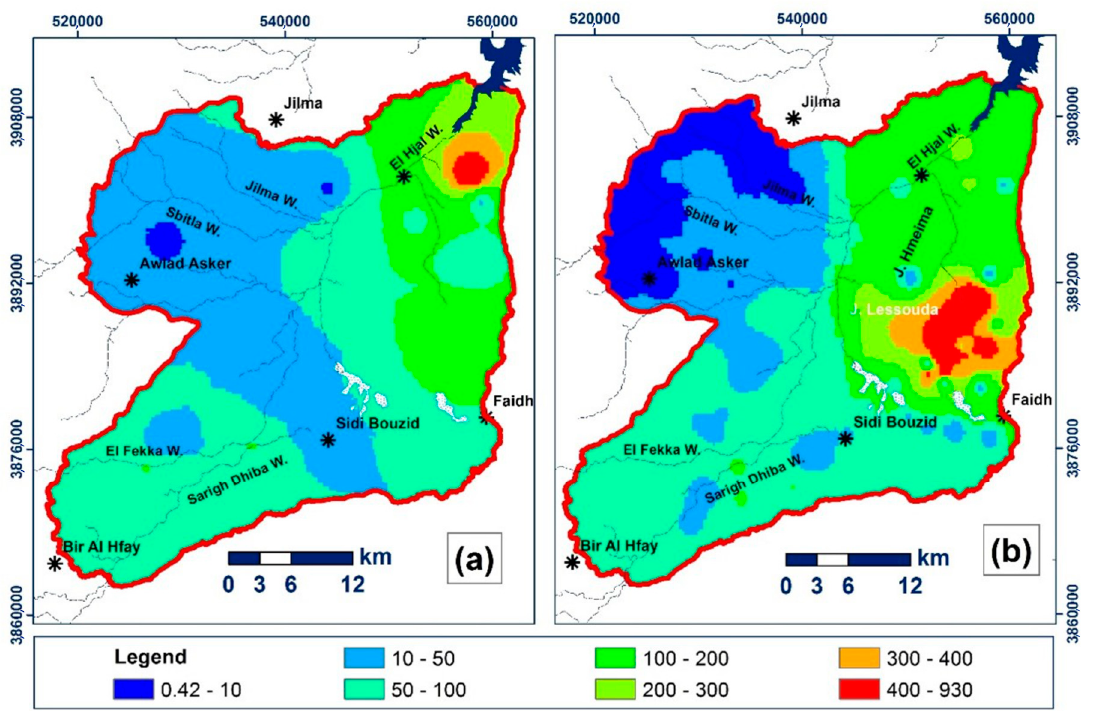
Figure 5. Spatial distribution of NO 3 − concentrations in groundwater: ( a ) shallow aquifer and ( b ) deep aquifer.